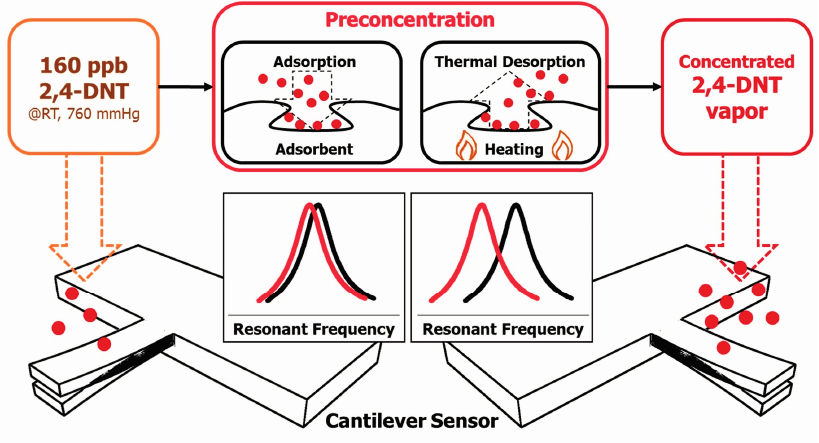
Figure 1. Functional model of the cantilever-based artificial olfactory system with sample preconcentration for 2,4-DNT vapor